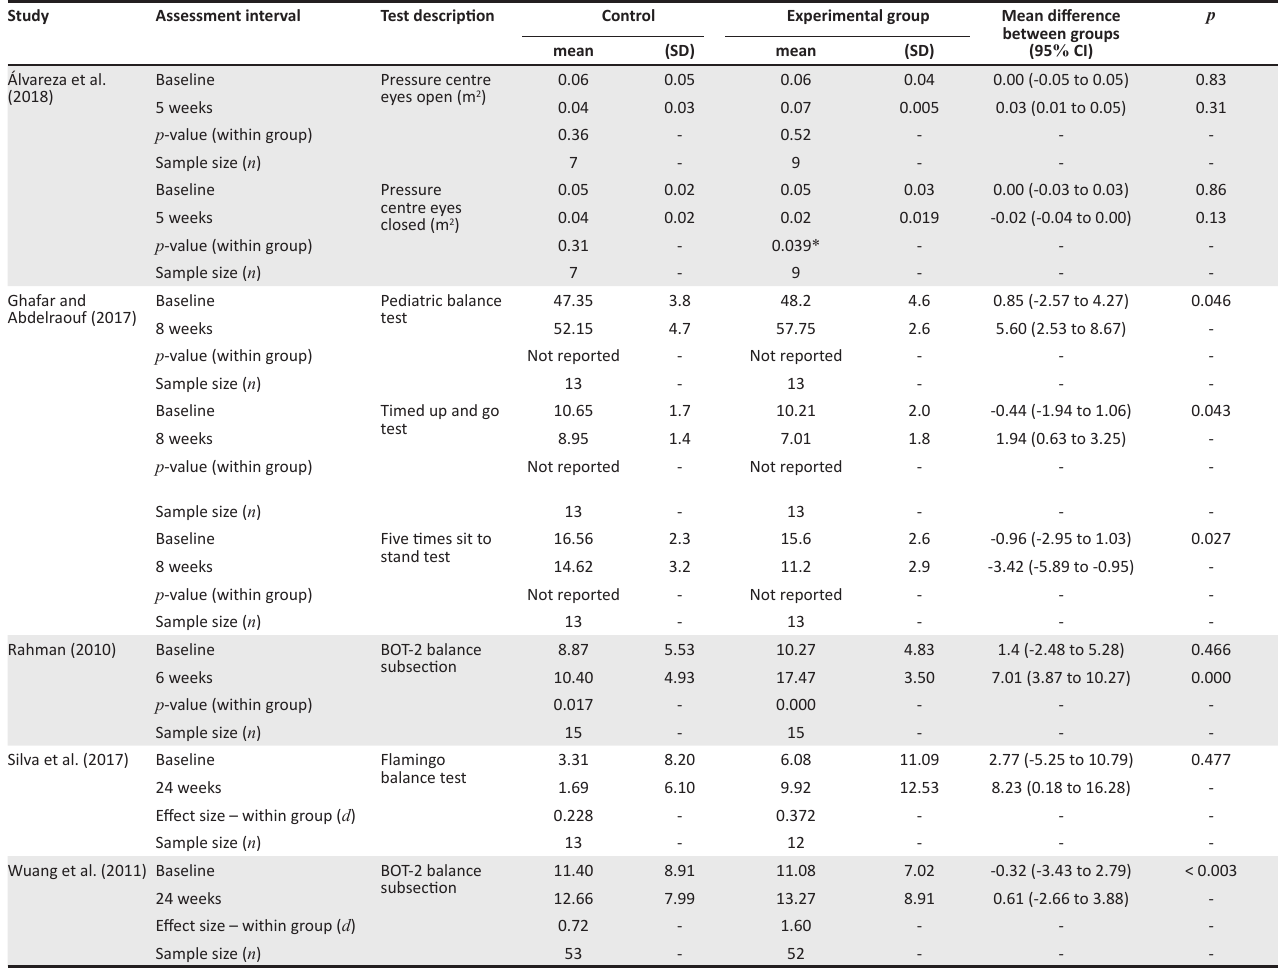
TABLE 4 : Results reported for balance measures of included studies. Study Assessment